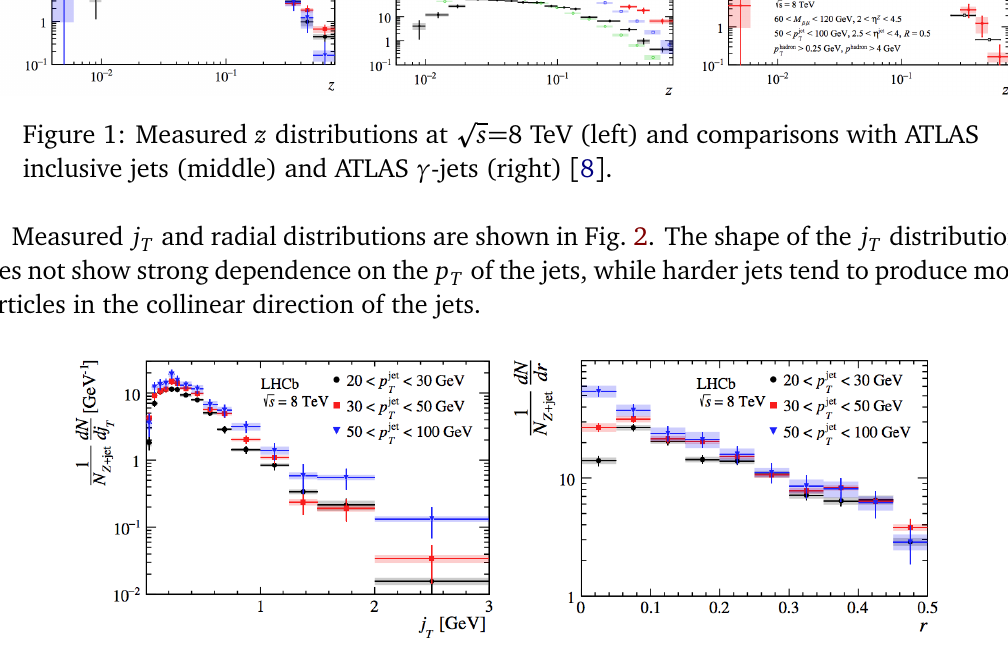
Figure 2: Measured j